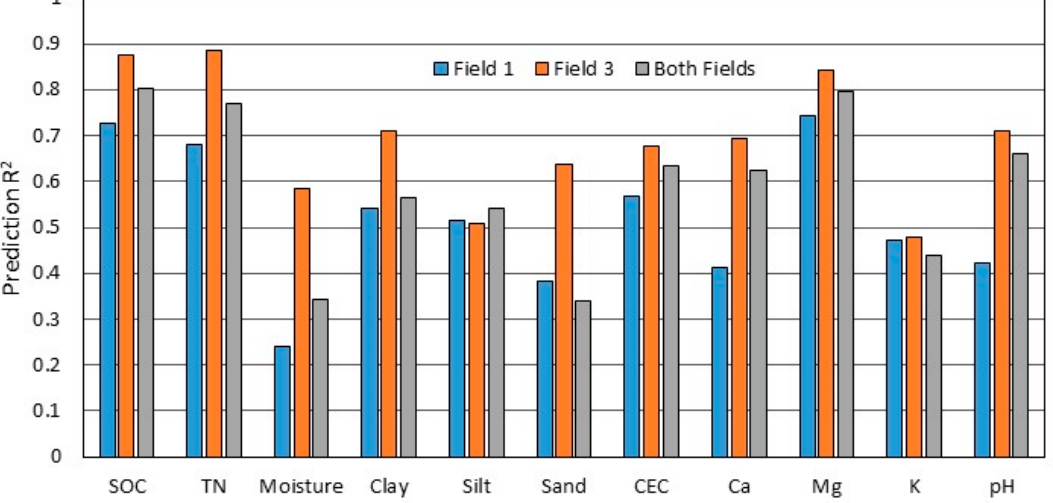
Figure 3. Prediction R 2 values comparing results from Field 1, Field 3, and the combination of both fields using partial least squares regression (PLSR) on the combined dataset including depth, EC a , CI and spectra (DECS).